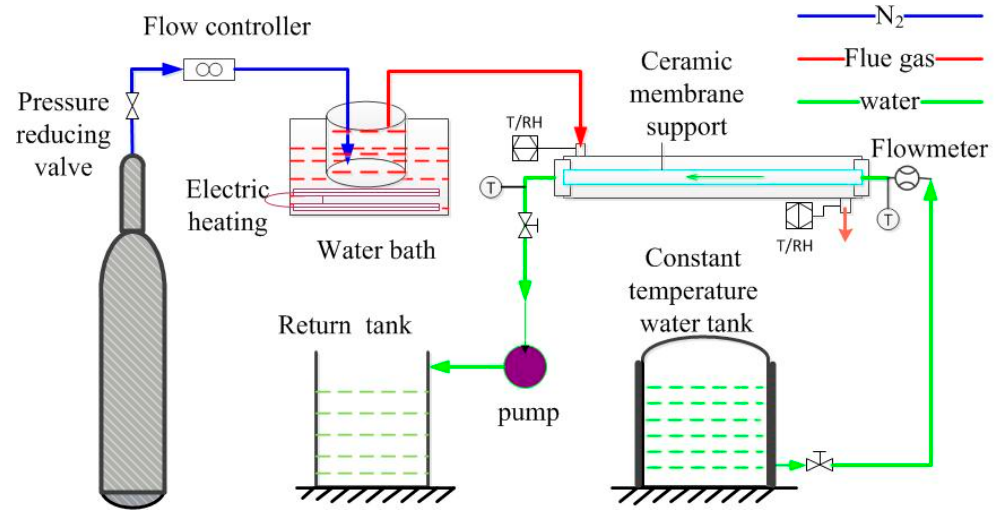
Figure 3. Diagram of the flue gas water recovery experimental system.